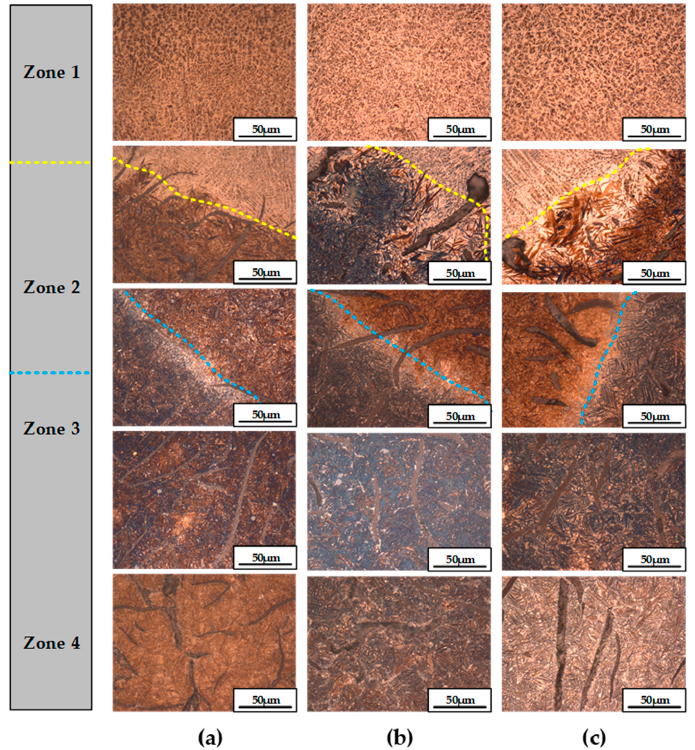
Figure 4. Microstructure of Difference Zones in the Matrix of Laser-Hardened Austempered Gray Cast Iron (LHAGI) Specimens with Various Austempering Temperatures ( a ) 232 ° C; ( b ) 288 ° C; ( c ) 343 ° C.